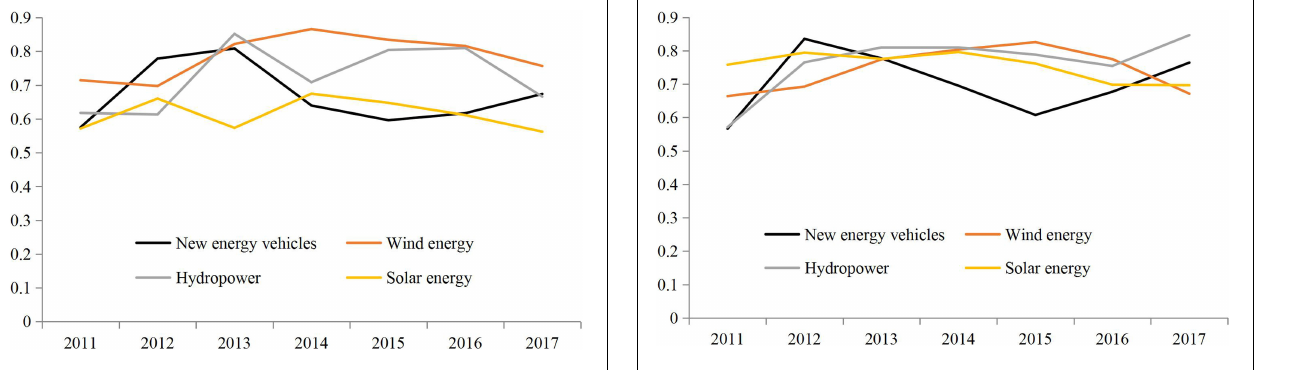
FIGURE 9 | The comprehensive correlation between the efficiency of four new energy industries and Green.